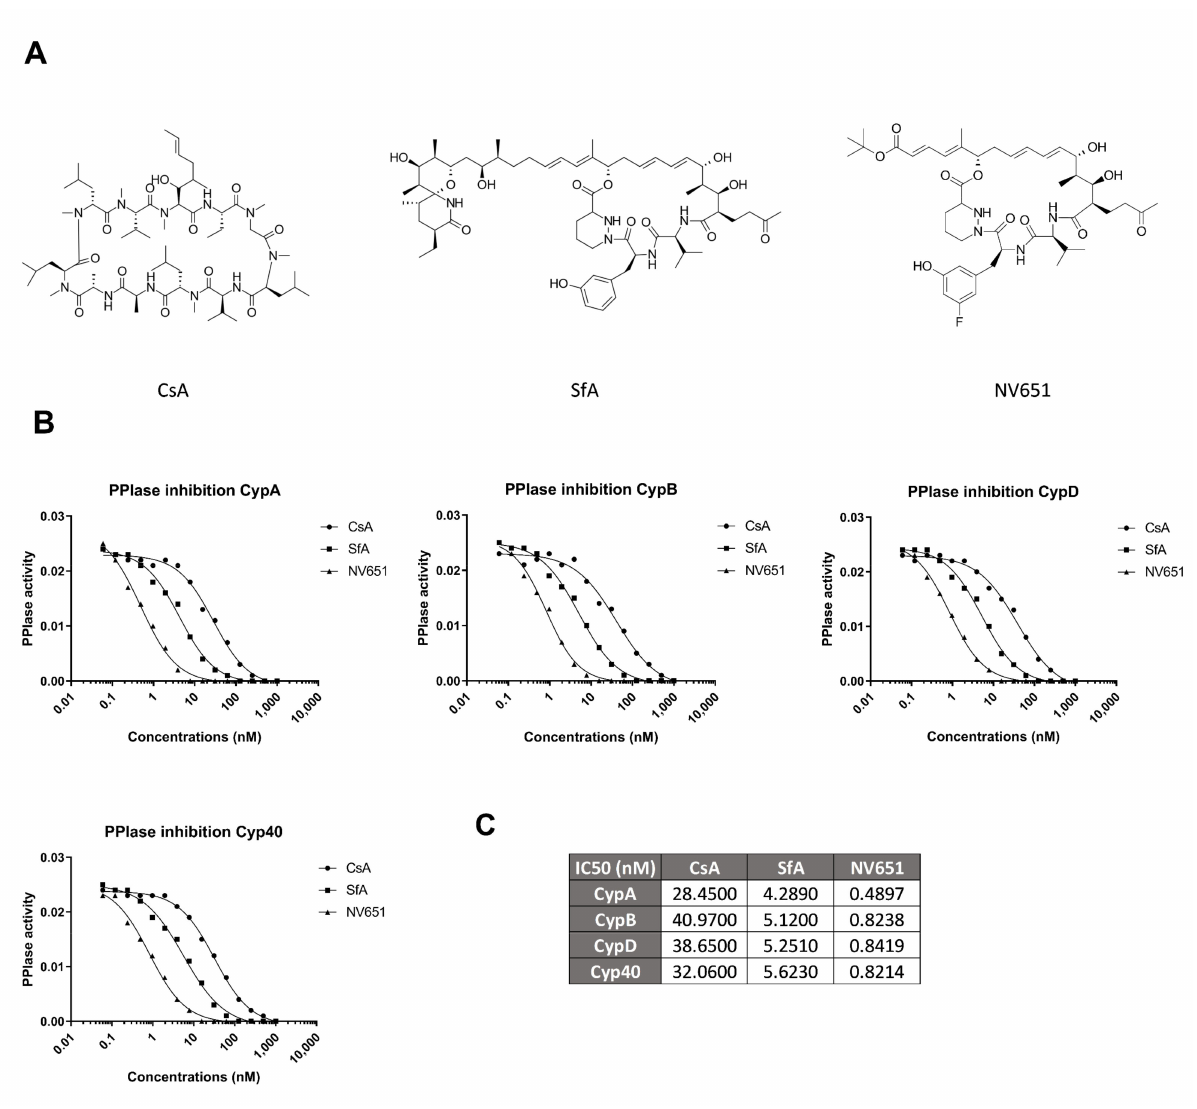
Figure 2. NV651 effect on cyclophilin activity. ( A ) Chemical structures of CsA, SfA and NV651. ( B ) PPIase activity of CypA, CypB, CypD and Cyp40 in the presence of different concentrations of the indicated drugs. The PPIase activity corresponds to the catalytic rate constants (seconds − 1 ). ( C ) Collection presenting the absolute IC 50 calculated from ( B